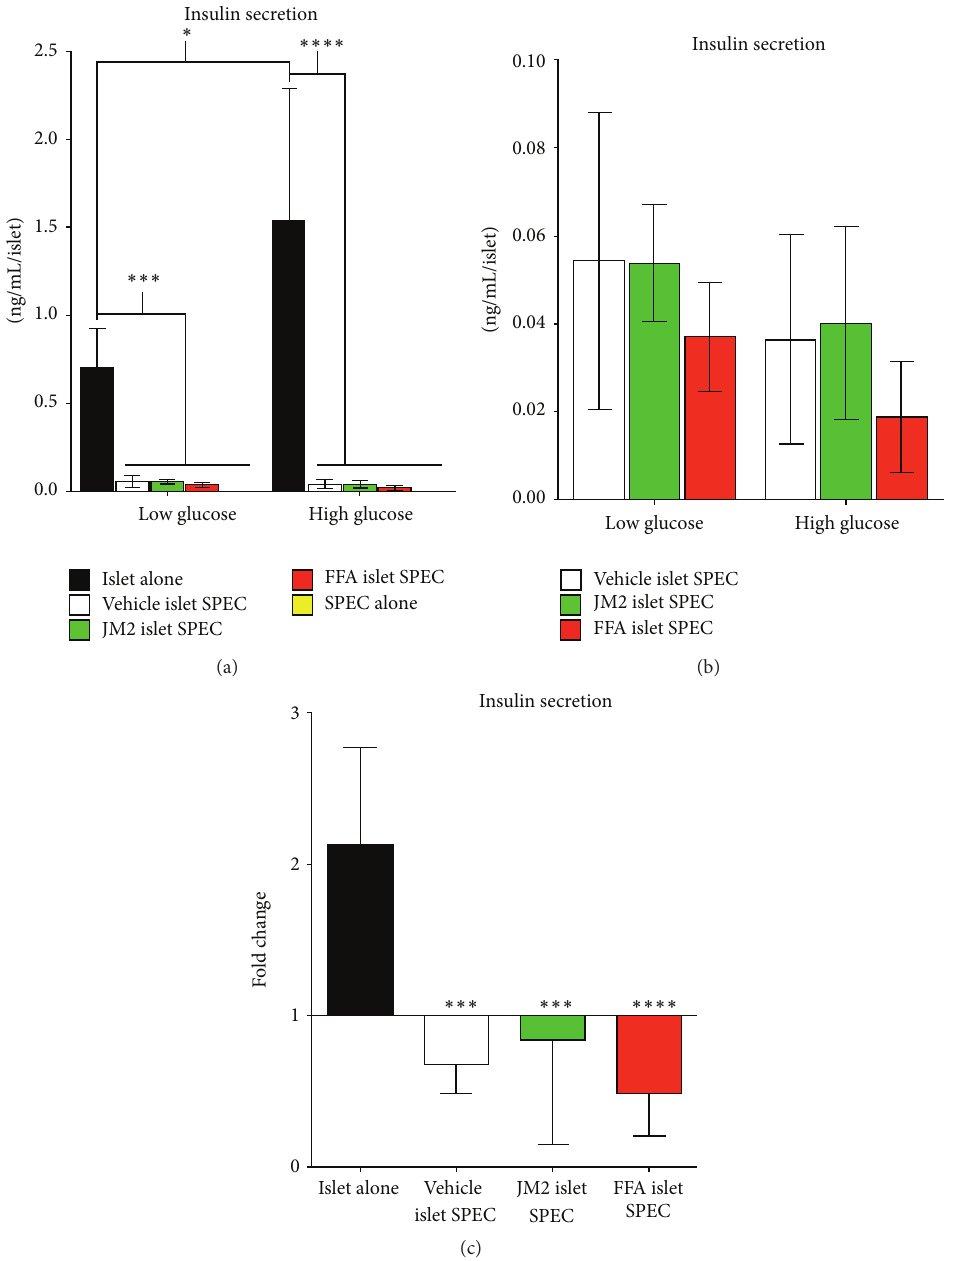
Figure 3: Islet-containing SPECs secrete low levels of insulin and fail to respond to high glucose stimulation. Islets alone, SPECs without islets, and islet-containing SPECs pretreated with vehicle, 50 𝜇 M JM2, or 50 𝜇 M FFA were subjected to GSIS assay by first stimulating with low glucose (2.8 mM) for one hour and then high glucose (28 mM) for one hour. Buffer was collected at the end of both stimulation periods and analyzed for insulin by ELISA. (a) The concentration of insulin secreted per islet for all treatment groups. Two-way ANOVA revealed that there was significant pairing ( 𝑃 < 0.01 ) and that glucose concentration and treatment were both significant sources of variation ( 𝑃 < 0.0001 and 𝑃 < 0.001 , resp.). Bonferroni post hoc analysis determined that within the low glucose group free islets alone secreted significantly more insulin than any of the islet-containing SPEC treatments ( 𝑃 < 0.001 , indicated on graph by ∗ ∗ ∗ ) and that, similarly, high glucose free islets secreted significantly more insulin than any of the high glucose islet-containing SPEC treatments ( 𝑃 < 0.0001 , indicated on graph by ∗ ∗ ∗∗ ). Paired 𝑡 -tests were used to compare high and low glucose conditions within treatment groups, and only free islets displayed a significant increase in insulin secretion upon high glucose stimulation ( 𝑃 < 0.01 , indicated on graph by ∗ ). (b) The graph in (a) was limited to comparisons between islet-containing SPECs to better resolve the graph bars. No significant differences were observed. (c) The relative change in insulin secretion from low to high glucose stimulation. One-way ANOVA with Bonferroni post hoc analysis showed that the islets alone had a significantly increased relative change in insulin secretion compared to any of the SPEC treatment groups ( 𝑃 < 0.001 ). These data show that islet-containing SPECs secrete very low levels of insulin and that they are refractory to high glucose